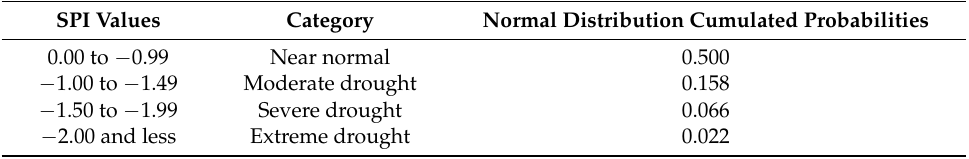
Table 1. Relationship between Standardized Precipitation Index (SPI) values and drought categories.